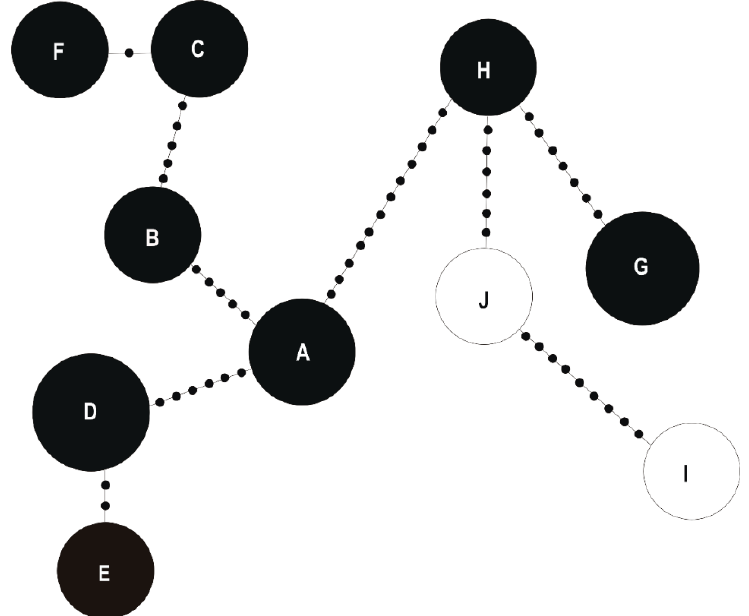
Figure 5. Minimum spanning tree (MST) based on a pairwise distance matrix computed on the basis of 900-bp 16S rRNA gene sequence analysis of studied genotypes (symbols A–J) of Stenotrophomonas maltophilia strains derived from the Boles ł aw, Saturn, and Bukowno waste heaps (metalliferous) and Bolestraszyce non-polluted (non-metalliferous) areas. The size of the circle corresponds to the genotype frequency in the whole sample. Small dots on the tree edges correspond to the differences in the number of different nucleotides in 900-bp 16S rRNA gene between nodes representing S. maltophilia genotypes (A–J). Dark parts of the circles correspond to the frequency of S. maltophilia strains with a given genotype in a metalliferous area.